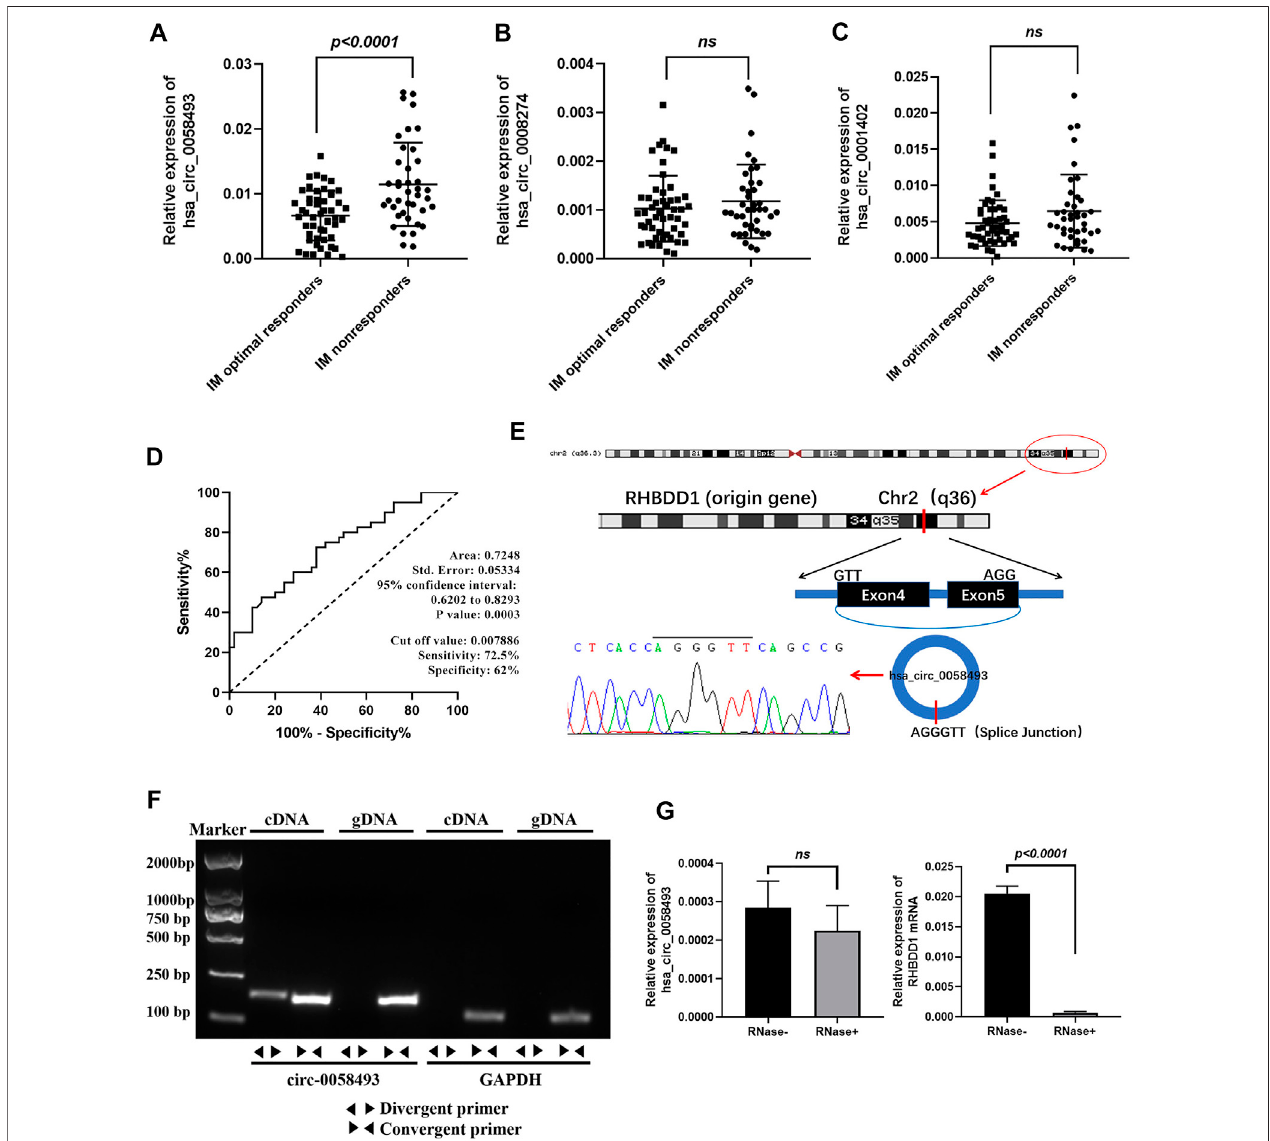
FIGURE 2 | Identi fi cation of hsa_circ_0058493 as a biomarker for CML. (A) hsa_circ_0058493 expression was signi fi cantly upregulated in PBMCs of IM nonresponders compared to IM optimal responders ( p < 0.0001). (B) hsa_circ_0008274 expression showed no statistical difference between the two groups. (C) hsa_circ_0001402 expression showed no statistical difference between the two groups. (D) The value of hsa_circ_0058493 as a prognostic biomarker in CML was evaluatedbyROCcurveanalysis.TheAUCofhsa_circ_0058493was0.7248,thecut-offvaluewas0.007886(sensitivity:72.5%;speci fi city:62%). (E) Theoriginof hsa_circ_0058493 was obtained from circBase online database. The splice junction sequence of hsa_circ_0058493 was veri fi ed by Sanger sequencing. (F) Divergent primers ampli fi ed hsa_circ_0058493 in cDNA but not in genomic DNA (gDNA). GAPDH served as a negative control. (G) RNA from K562/G01 cells was treated with or without RNase R for RT-qPCR. The relative levels of circ_0058493 and RHBDD1 mRNA were normalized to the values of GAPDH measured in the RNase R-group. Quantitative data from three independent experiments are shown as the mean ± SD (error bars). ns: not statistically signi fi cant (Student ’ s t -test).